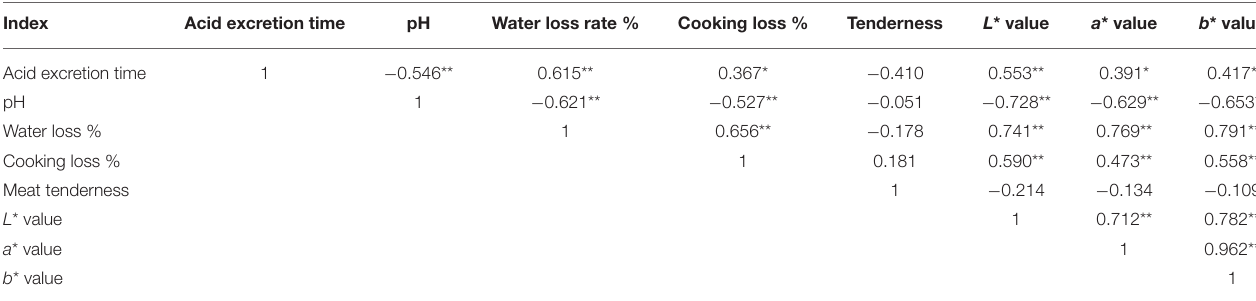
TABLE 5 | Correlation analysis of meat quality index in Simental beef in the process of